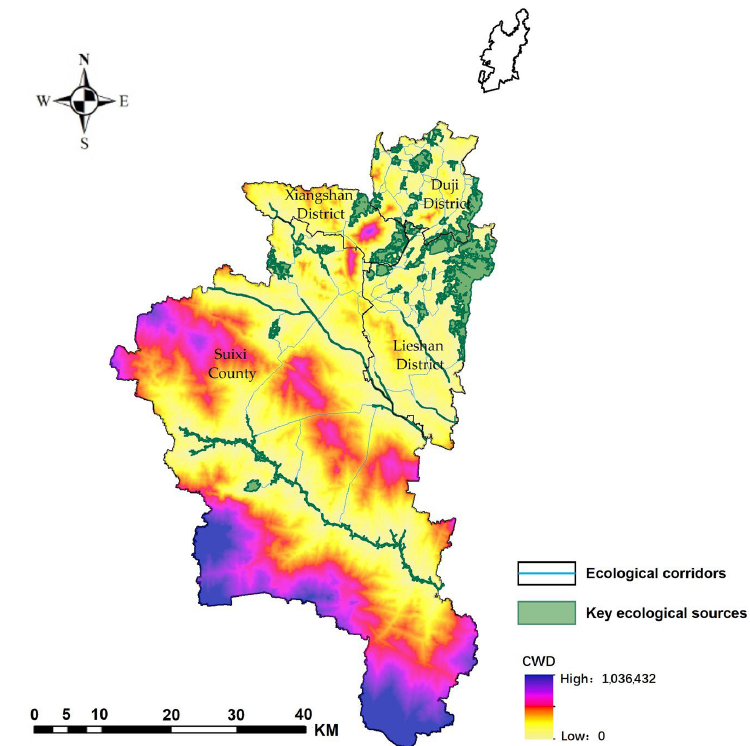
Figure 10. Spatial distribution of